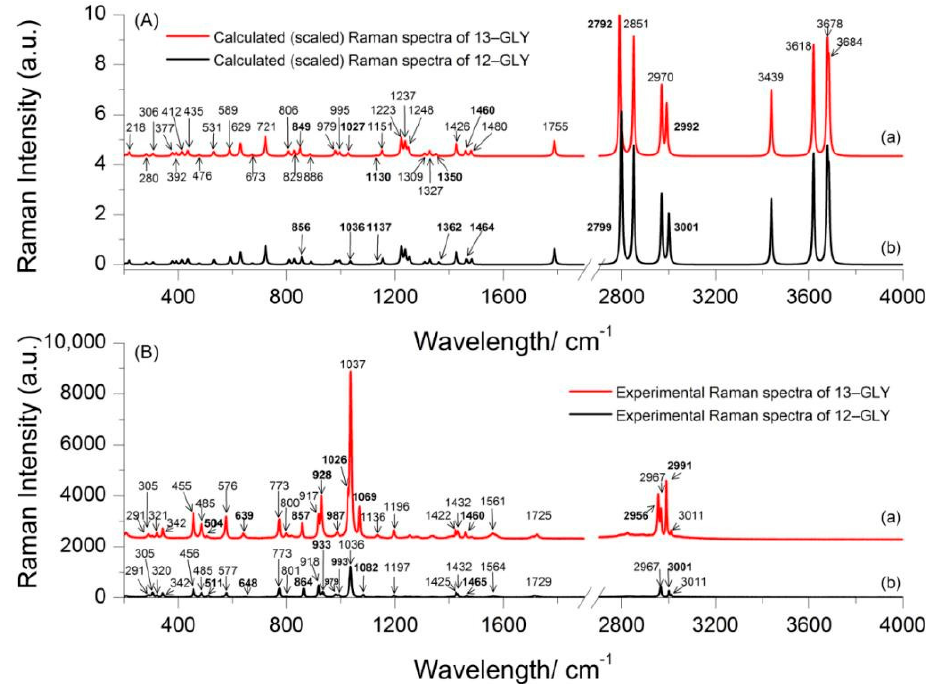
Figure 2. Experimental and calculated (scaled) Raman spectra of 2- 13 C-glyphosate (13–GLP) and glyphosate (12–GLP) in the spectral region 200 and 4000 cm − 1 ( A ) calculated (scaled) Raman